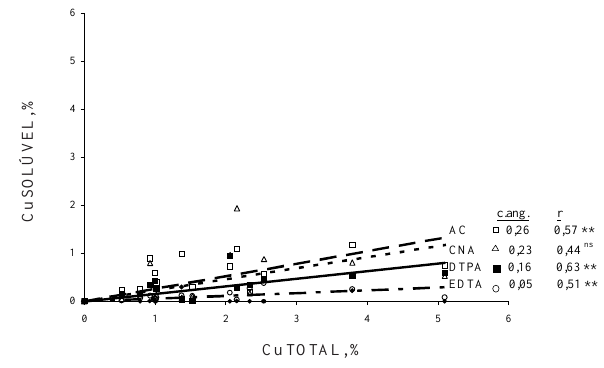
Figura 4. Solubilidade do cobre presente em fertilizantes insolúveis em água, nos diversos extratores utilizados, e respectivos coeficientes angulares das retas (c.ang.) e coeficientes de correlação (r). ** e ns significativos a 5% e não- significativo,